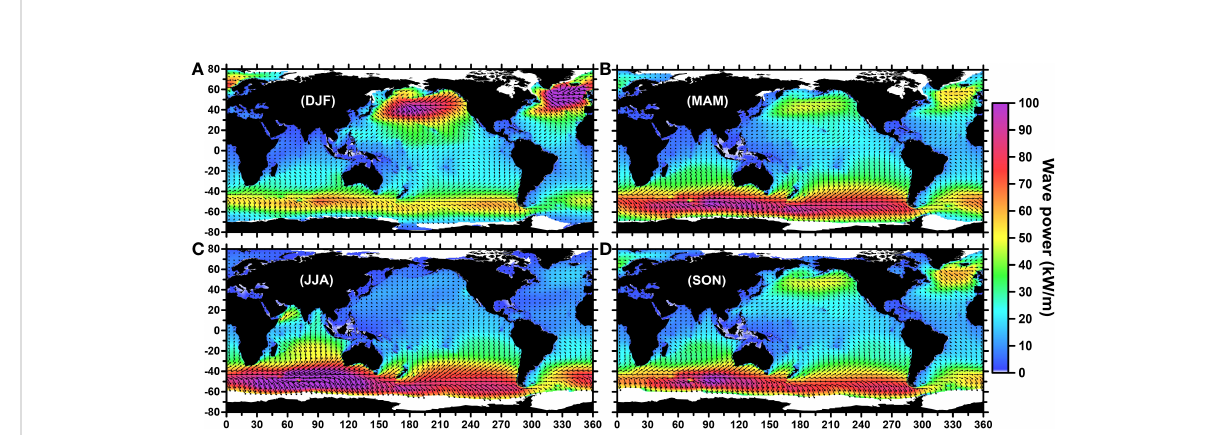
FIGURE 5 Seasonal distribution of the averaged wave power (seasons correspond to the Northern Hemisphere). (A) Winter (DJF: December, January, February), (B) spring (MAM: March, April, May), (C) summer (JJA: June, July, August), and (D) autumn (SON: September, October, November).